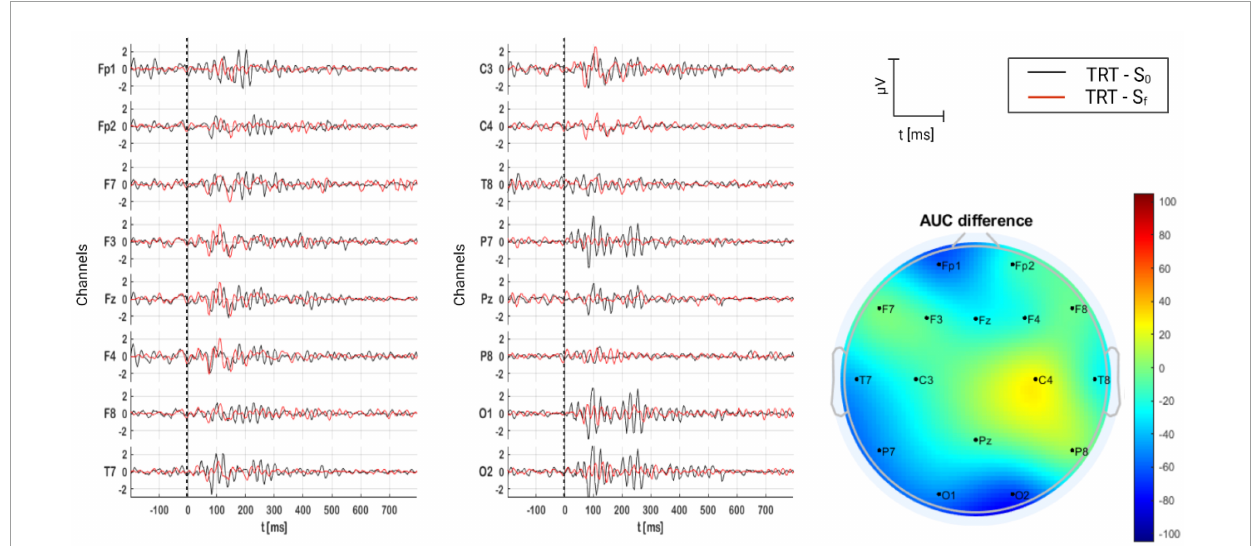
FIGURE9 Grand average of AERPs at S 0 (initial session) and S f (final session) for TRT group. In addition, the AUC difference of these two grand averages (S f – S 0 ) is topographically plotted in µ V.